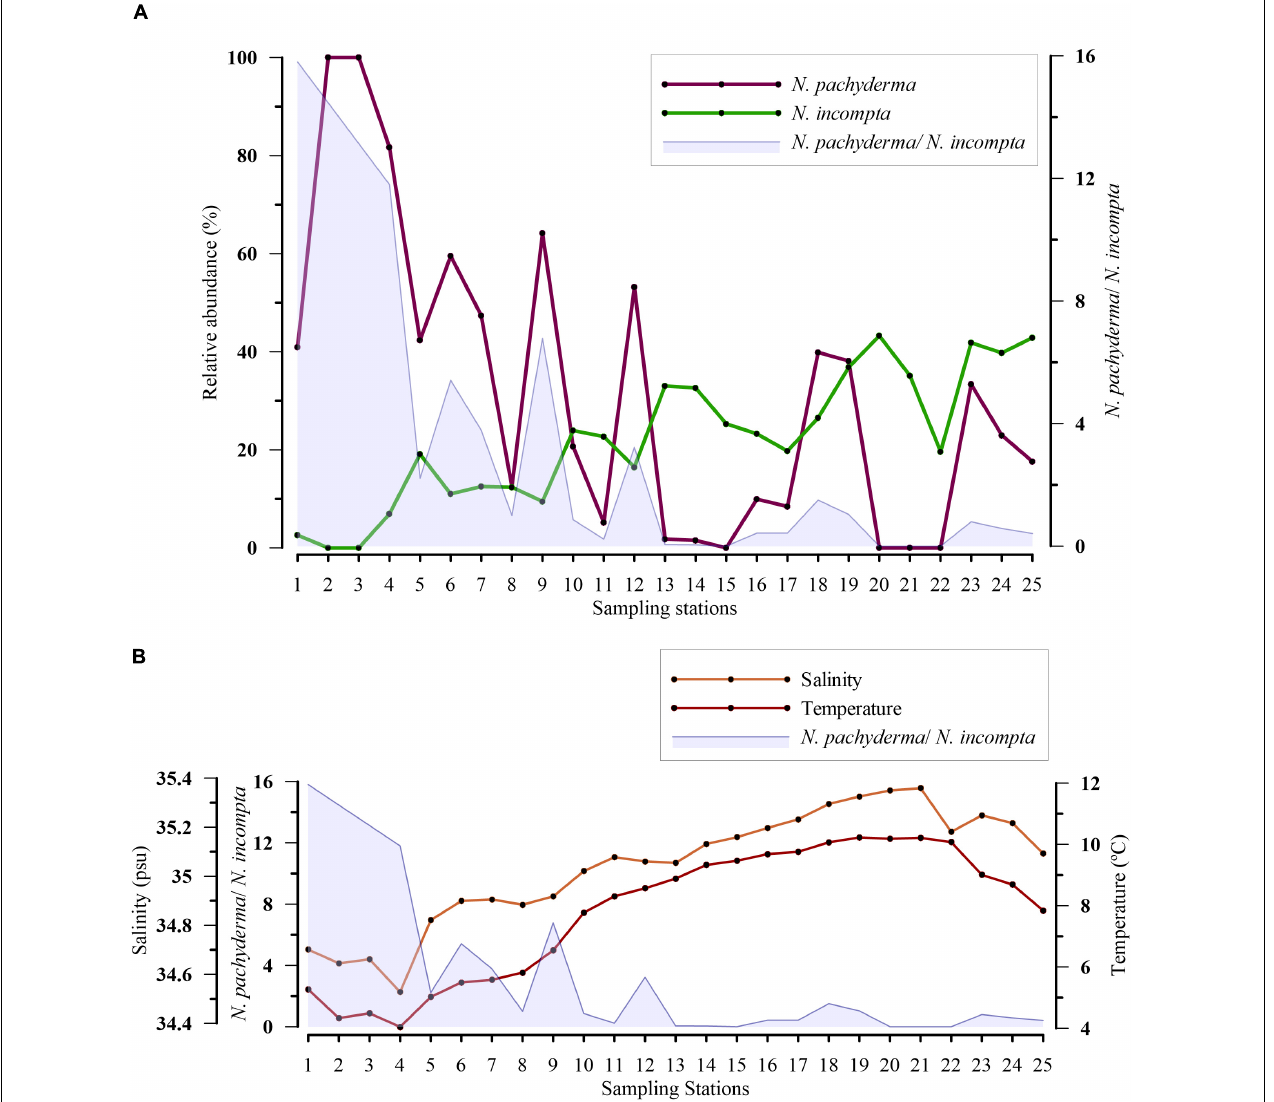
FIGURE 5 | (A) Variation in relative abundance (%) of Neogloboquadrina pachyderma ( N . pachyderma ) and Neogloboquadrina incompta ( N . incompta ) along the transect and variation in the ratio of N . pachyderma / N . incompta against the sampled stations is shown in blue; (B) Plot showing a relation between the ratio of N . pachyderma and N . incompta abundance with sea surface temperature and